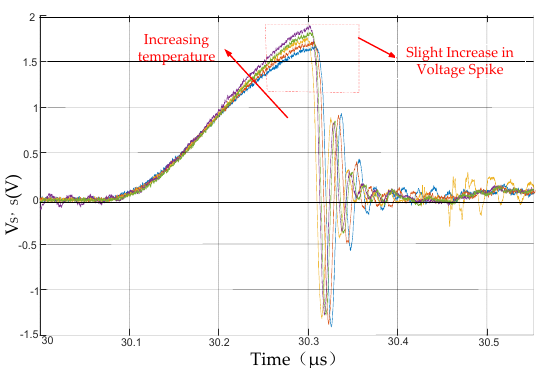
Figure 10. Parasitic inductance induced voltage waveforms at different DC ‐ link voltages.